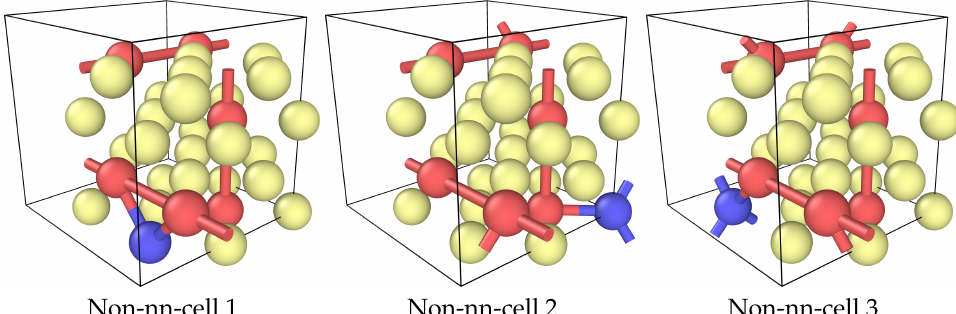
Figure 4. The three geometrically distinct positions of an alloying atom in the energetically best cell Ni 25 Cr 6 X from Figure 2. Nearest-neighbor bonds between the alloying atom and Cr and next-nearest- neighbor bonds between Cr atoms are shown. Ni atoms in yellow, Cr atoms in red, alloying element in